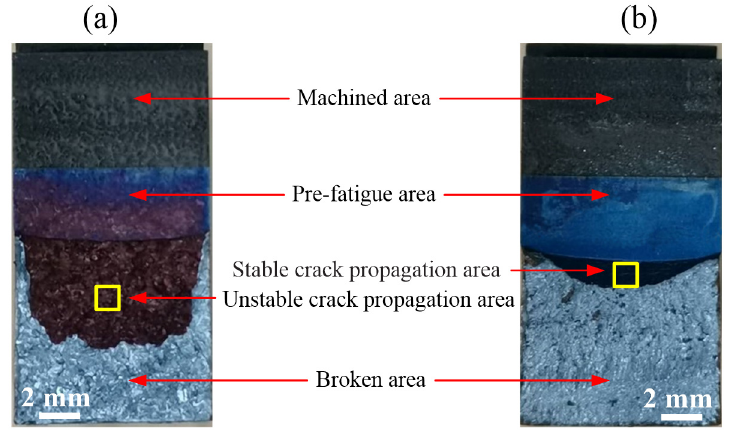
Figure 5. Macroscopic fracture surface. ( a ) Unstable propagation observed with BM-1. ( b ) Stable propagation observed with HAZ-1, BL, WM, HAZ-2, and BM-2.